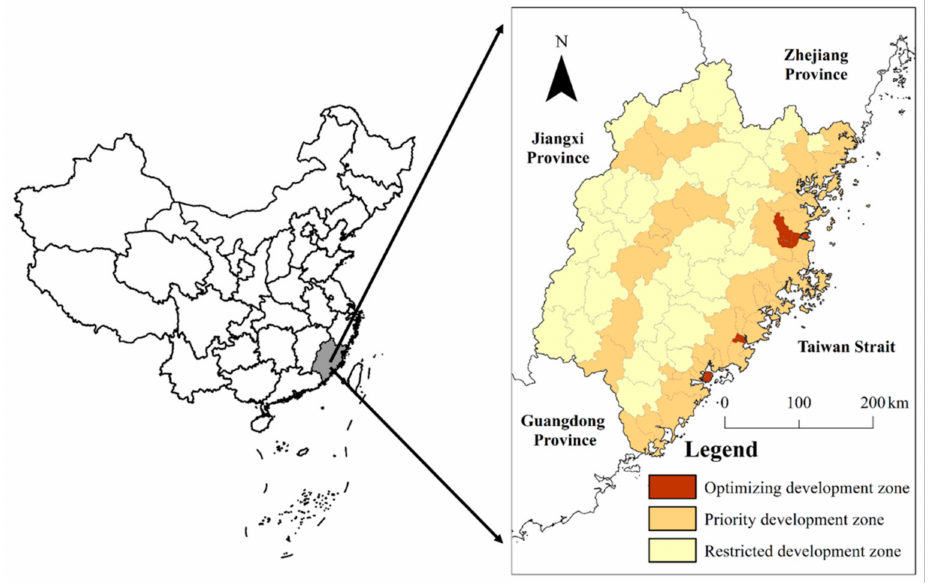
Figure 1. Location of Fujian Province and county-level functional